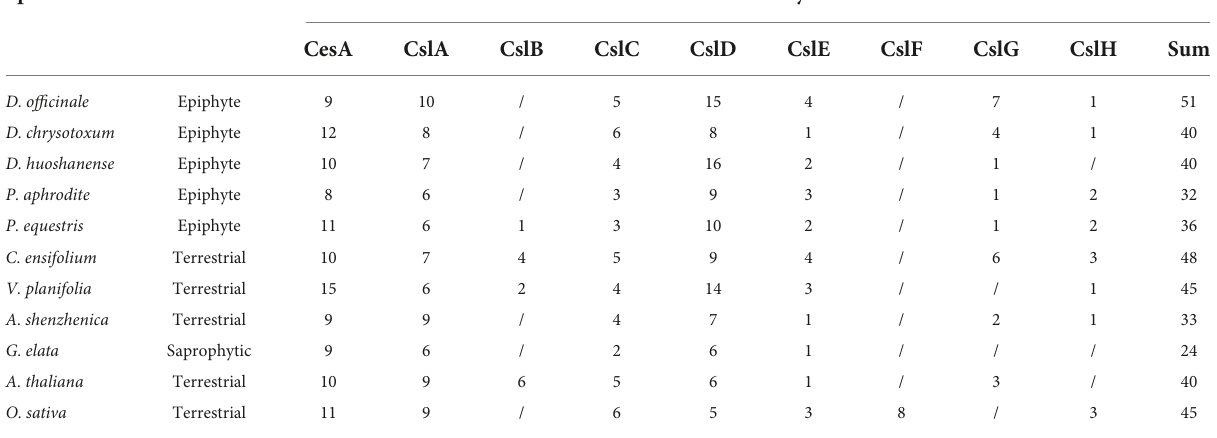
TABLE 1 Members of CesA/Csl gene family in nine orchid species, A. thaliana, and O. sativa. Species Life